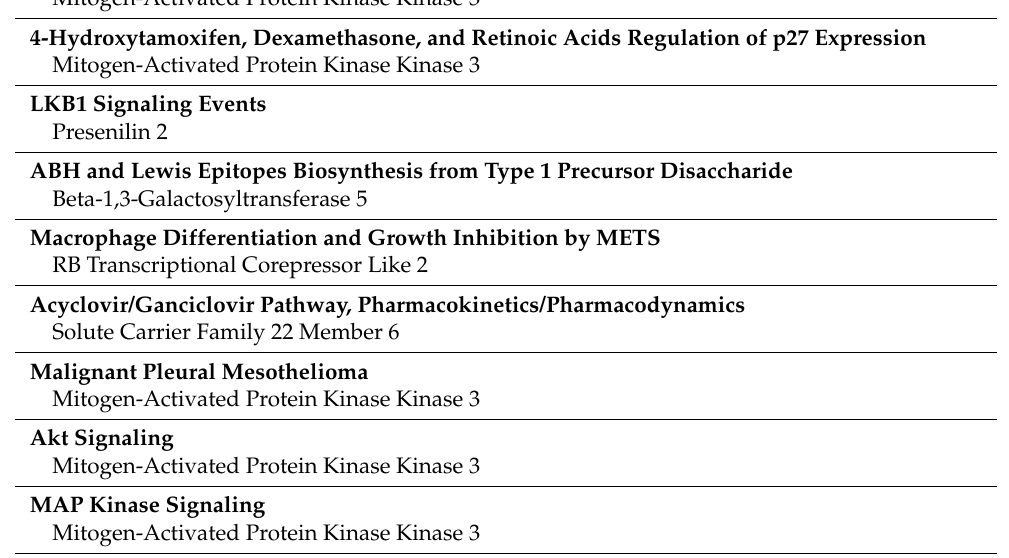
Table A2. Cont. JNK (c-Jun kinases) Phosphorylation and Activation Mediated by Activated Human